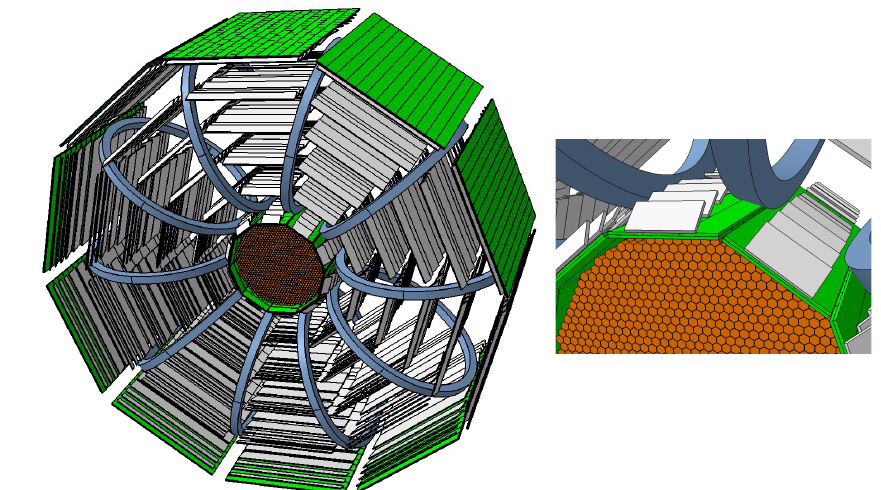
Figure 2. Left: Graphical rendering of the baseline design for the ALADInO detector. The core of the apparatus is a cylindrical calorimeter (orange). Ten circular magnetic coils (blue) surround the calorimeter. A silicon tracking system (gray) is arranged in six planes, each composed of several modules. Two time-of-flight planes (green), each composed of two layers of segmented scintillator paddles placed in hodoscopic configuration, are located on top of the outer tracker plane and below the innermost tracker plane. The increasing active area coverage towards the outer region of the coils minimizes the detector size and weight optimizing the combined spectrometer and calorimeter acceptance. Right: Detail of the central part of the instrument. The adaptive orientation of the tracker sensors is set to maximize the trajectory measurement resolution. Figure readapted from[96] under license CC BY 4.0.